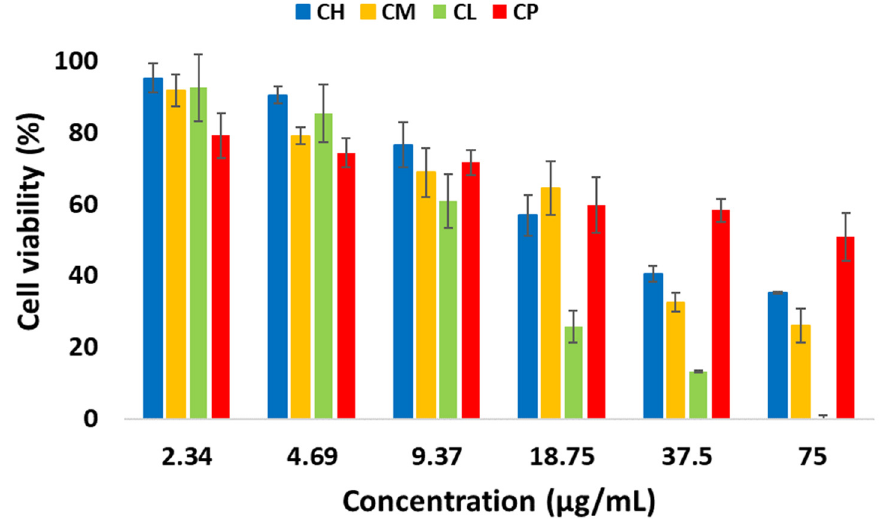
Figure 4. Antiproliferative activity of the four Citrus spp. leaf oils against the HeLa cervical cancer cell line. C. hystrix (CH), C. limon (CL), C. pyriformis (CP), and C. microcarpa (CM). Values are means of three replicates ± standard deviation. p ‐ values < 0.01, as determined using one ‐ way ANOVA.